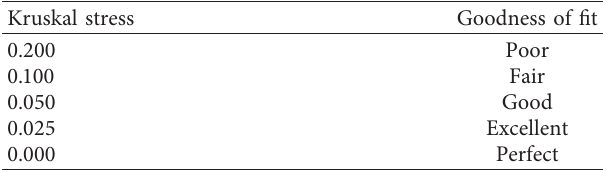
Table 4: Relation between Kruskal stress and goodness of fit. Kruskal